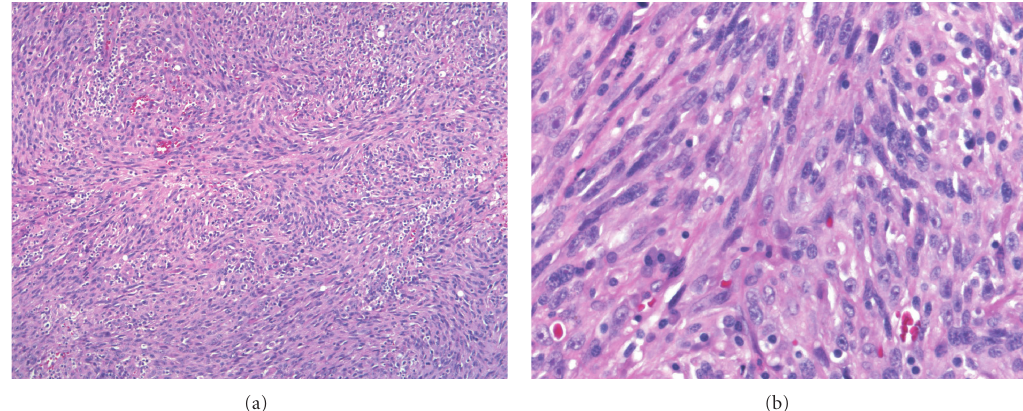
Figure 2: Representative light photomicrographs from the spindle areas of the excision. (a) Low power showing a fascicular growth pattern of spindle cells with occasional slit-like vascular spaces, and lymphoplasmacytic infiltrate. (hematoxylin-eosin, original magnification × 10). (b) Close-up view showing sheets of spindle cells, with few intracytoplasmic hyaline globules and occasional slit-like vascular spaces. (hematoxylin-eosin, original magnification × 40).